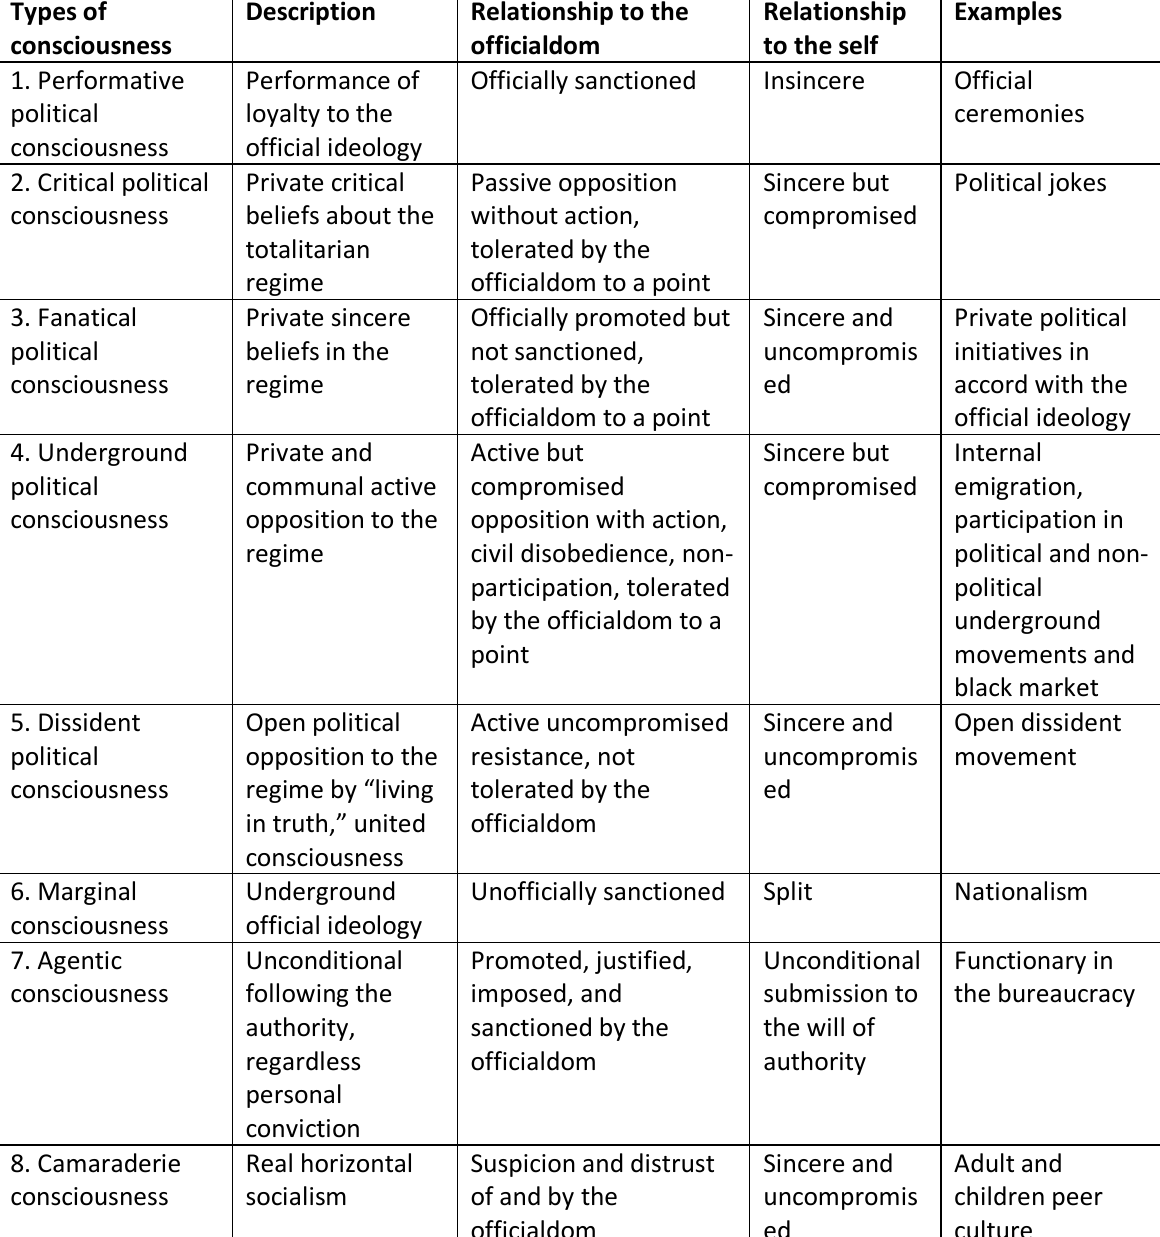
Table 1. Types of observed political consciousness in the Soviet Union Types